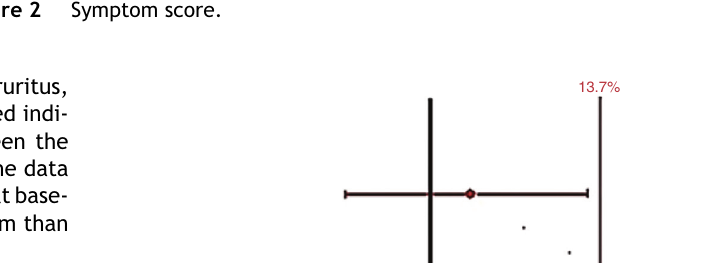
Favors control drug